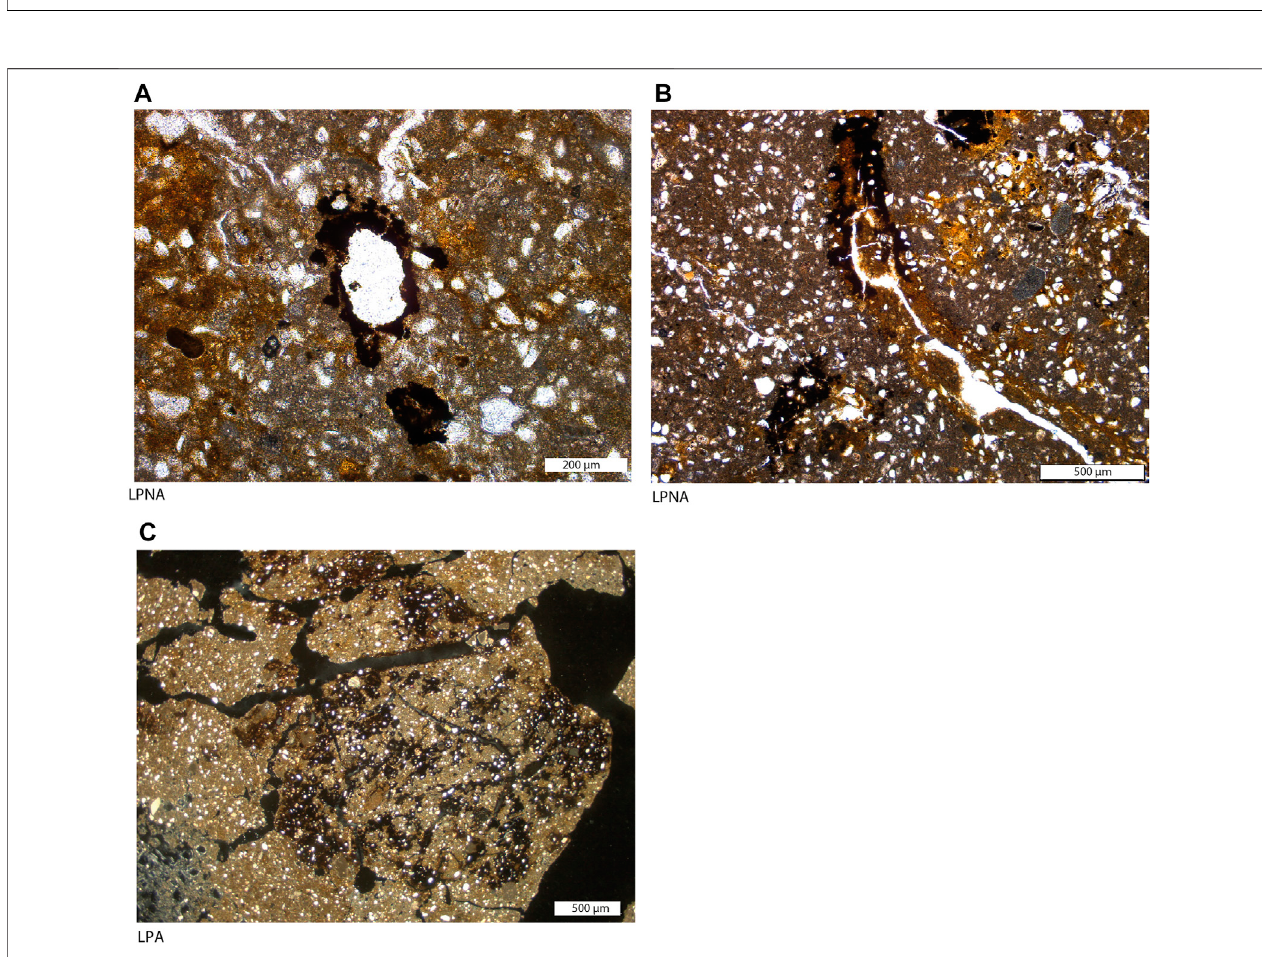
Frontiers in Earth Science |